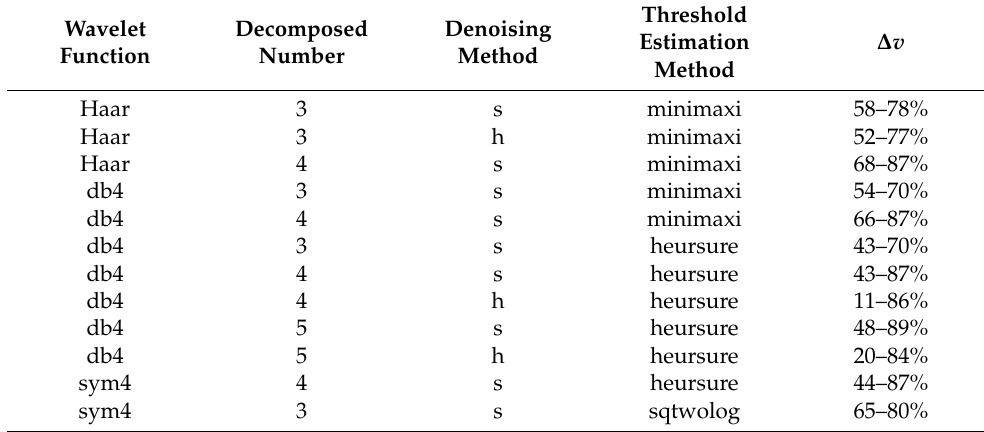
Table 4. The effects of eliminating the data test noise and capacity recovery by wavelet